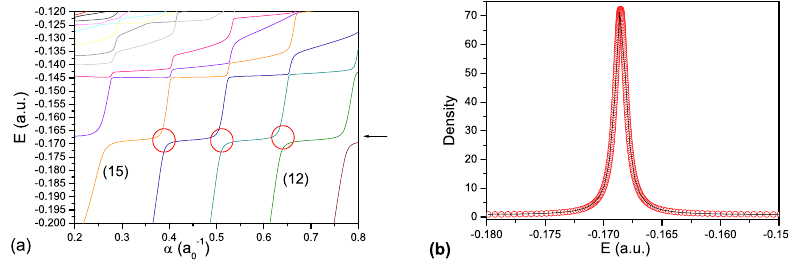
Figure 1. ( a ) Stabilization diagram for µ = 0.0 obtained by using 525 terms in the wave function (5). The number in parentheses to the right of the solid line indicates the order of appearance of the eigenvalues (energy levels). The arrow shows the position of resonance, and the circles show the point of avoided crossing; ( b ) The density of resonance states fitted to the Lorentzian form for µ = 0. The circles are the calculated values, and the solid line is the fit function. The resonance parameters are determined to be E r = − 0.16855 a.u. and Γ = 0.00113 a.u. using the 13th